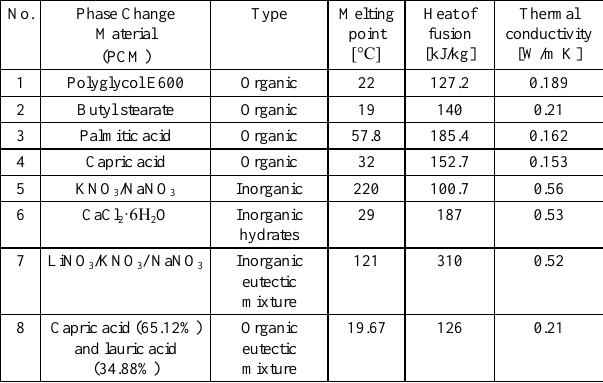
Table 2. Phase change materials and their thermal properties